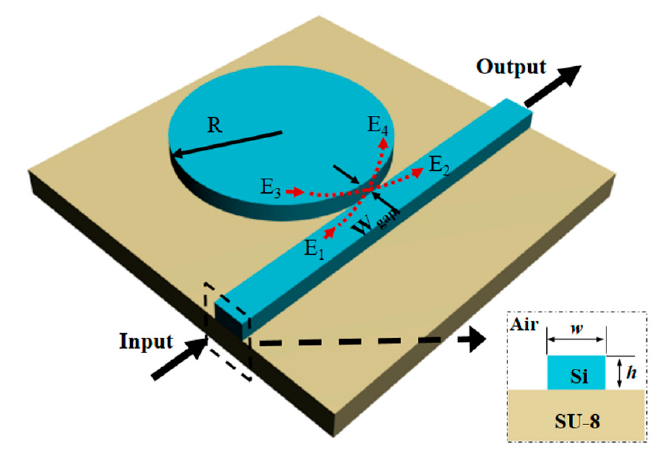
Figure 1. The diagram of the microdisk structure and the section dimension of the bus waveguide.